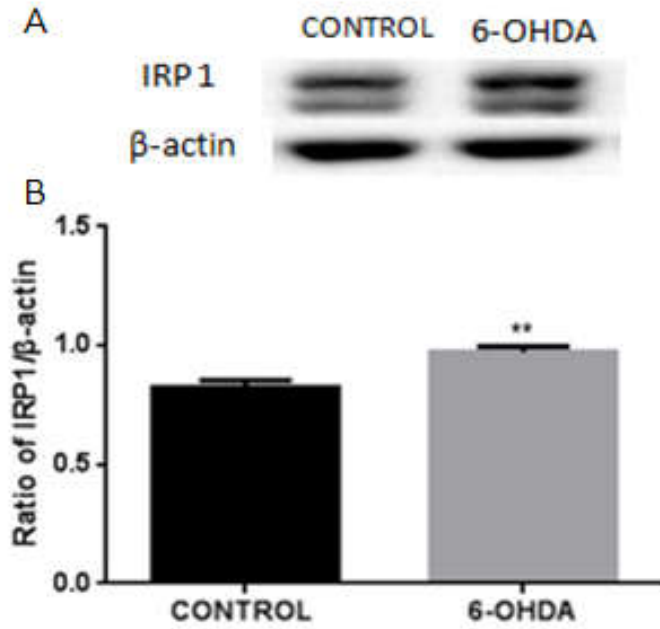
Figure 2. The protein levels of IRP1 in the 6-OHDA-treated BV2 cells. ( A ) Western blot analysis to detect IRP1 protein levels. Increased expression of IRP1 was observed in 10 µ M of 6-OHDA treated BV2 microglial cells. β -actin was used as the loading control. ( B ) Data are presented as the ratio of IRP1 to β -actin levels. Each bar represents the mean ± SEM from six independent experiments. n = 6. ** p < 0.01, compared with the control